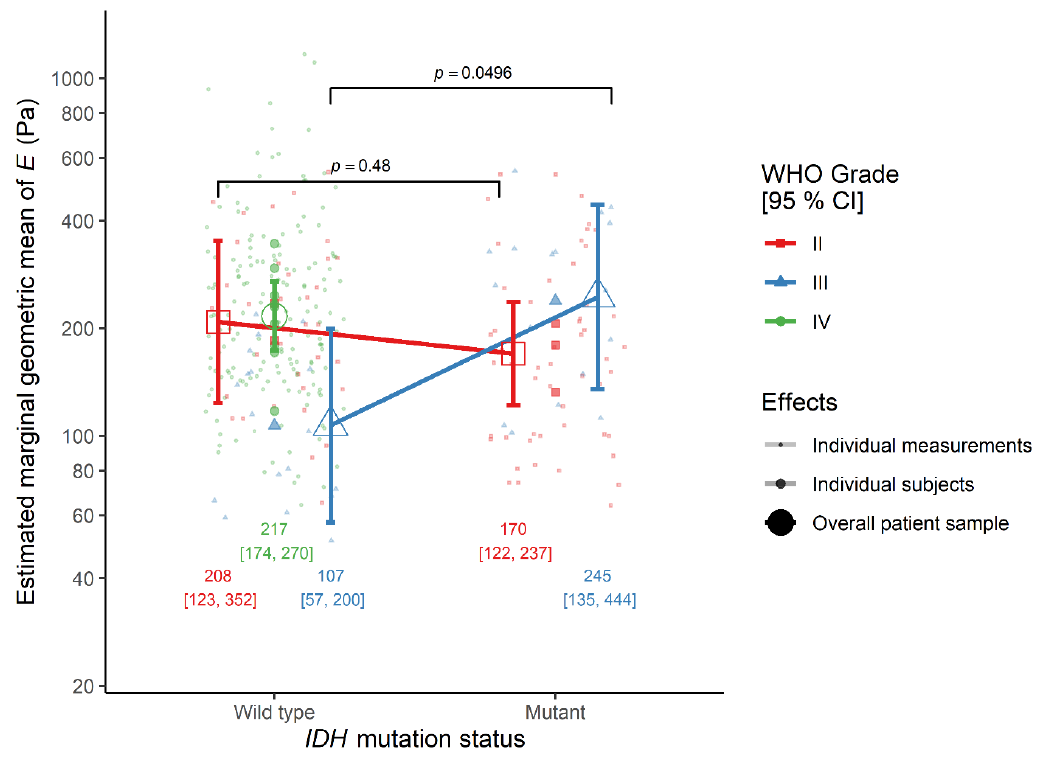
Cancers 2021 , 13 , x FOR PEER REVIEW Figure 1. The interaction effect between IDH mutation status and WHO grade on the elastic modulus E in the monotonic indentation model. IDH, isocitrate dehydrogenase gene family; WHO, World Health Organization.